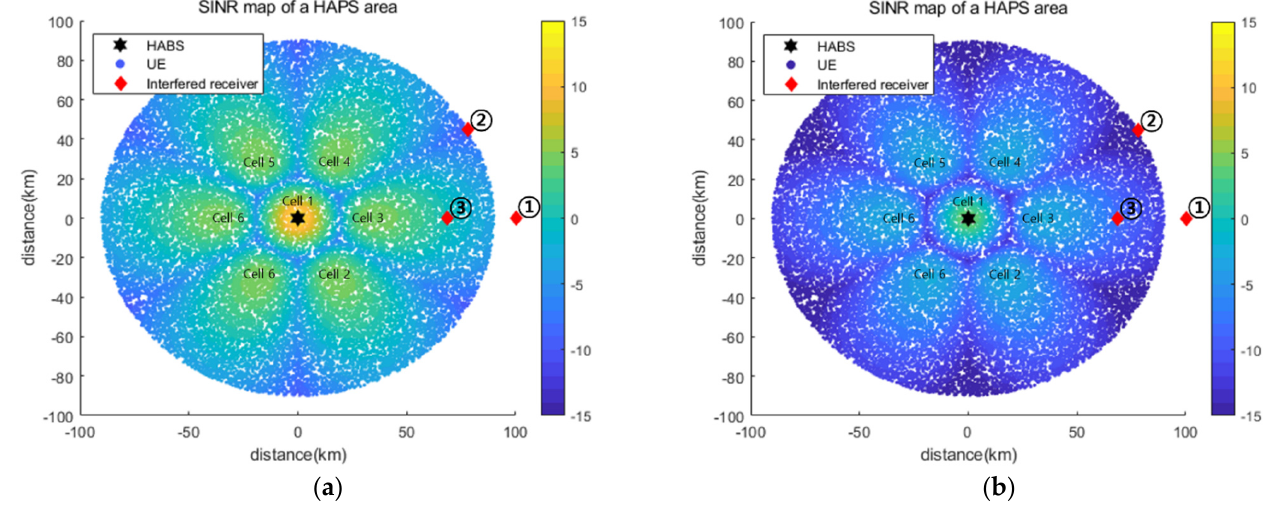
Figure 8. ( a ) SINR map for 𝑷 (cid:3040)(cid:3028)(cid:3051) ; ( b ) SINR map for 𝑷 (cid:3040)(cid:3036)(cid:3041) . Table 3. 𝐼𝑁𝑅 and 𝑃 (cid:3042)(cid:3048)(cid:3047) for the interfered receiver locations.